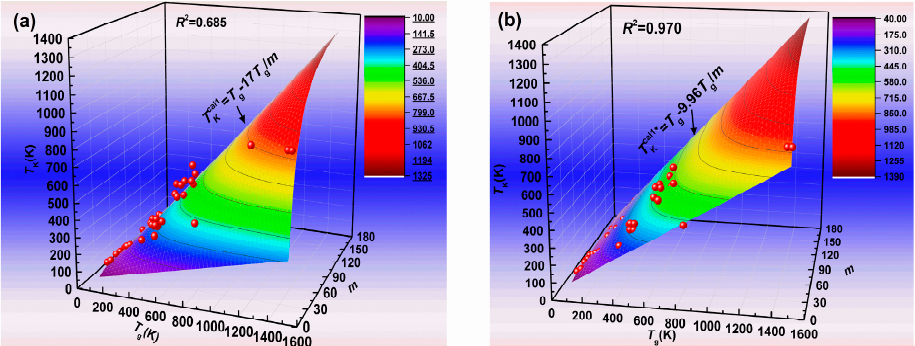
Figure 2. The predicted Kauzmann temperature obtained by Equation (9). ( a ) m min = 17; ( b ) m min = 9.96. Table 1. The values of T g , T K , and m for various glass-forming liquids. The data (numbers 19–38) were taken from Ref. [17,33].